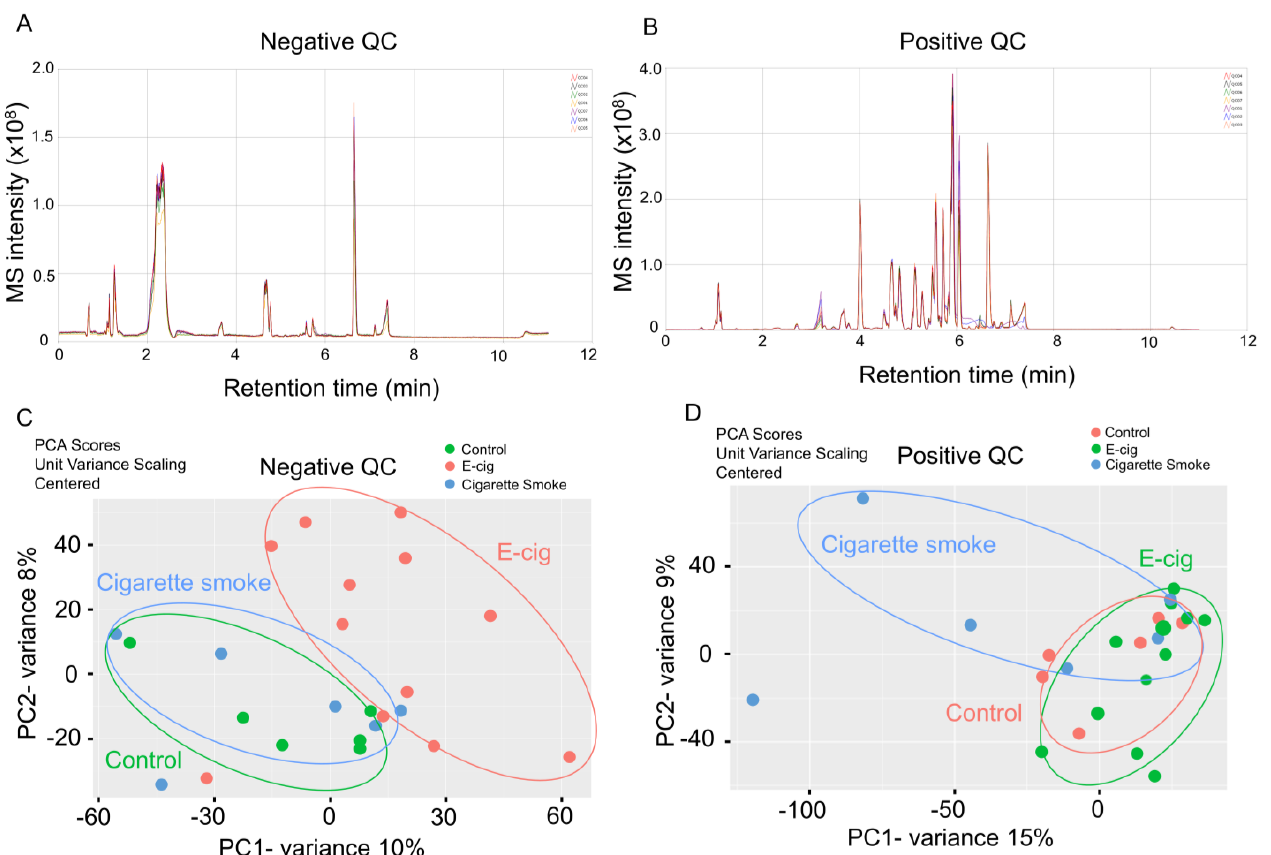
Figure 1. Metabolites from plasma were analyzed from ultra-performance liquid chromatography mass spectrometry (UPLC-MS). Spectra from UPLC-MS measured from ( A ) negative and ( B ) positive ion modes were used to identify individual metabolites. Score plots including all samples from principal component analysis (PCA) based on ( C ) negative and ( D ) positive ion modes presented dysregulated metabolomics affected by e-cig vaping and cigarette smoking.